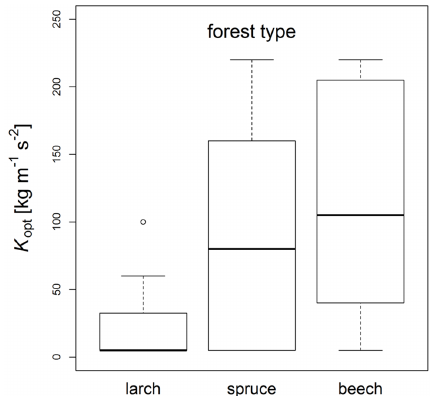
Figure 6. Optimal K values ( K opt ) assigned to each observed avalanche based on simulations with varying values of K shown for subsets of different forest types. Boxplots show minimum values, the lower quantile ( Q 0.25), the median ( Q 0.5), the upper quantile ( Q 0.75) and maximum values of K opt . Point is relative position of extreme